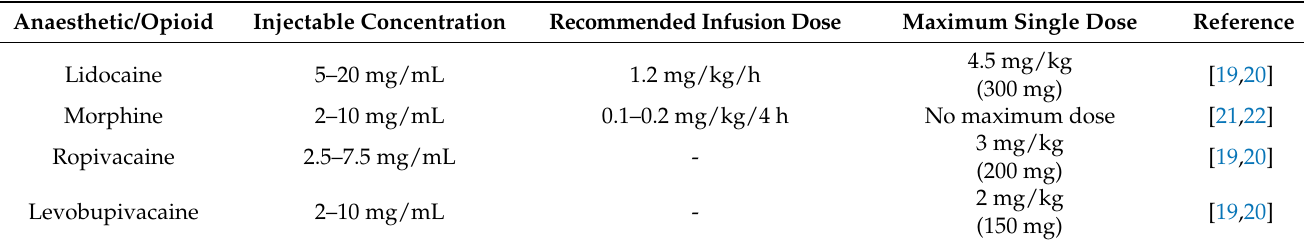
Table 1. Clinically recommended concentrations of anaesthetics/opioids used in this systematic review.